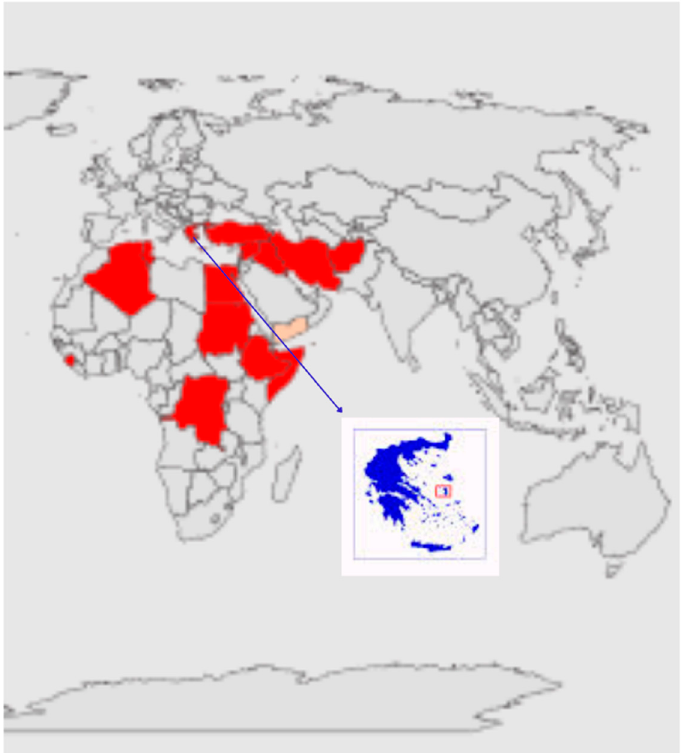
Figure 1. Immigration flows to Aegean Islands in 2015. Blue color: Country of Greece. Red circle in blue color: The catchment area of MMHU-Ch.